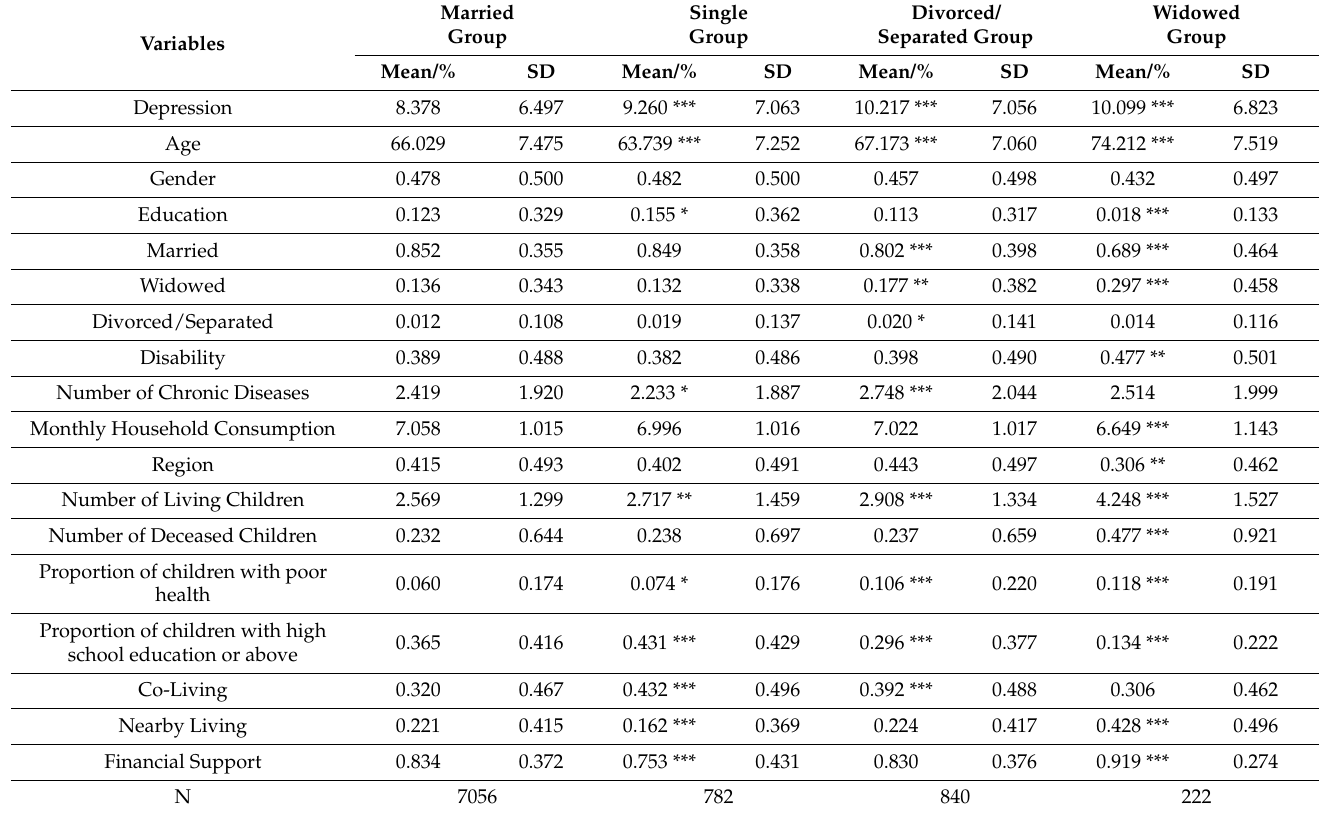
Table 1. Descriptive statistics of the